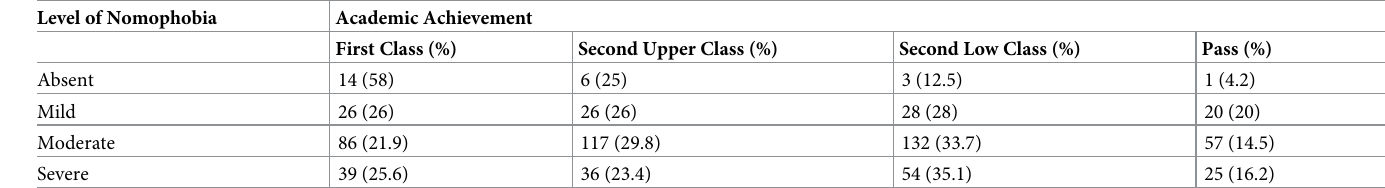
Table 8. Levels of nomophobia prevalence and academic achievement ( N = 670 ).